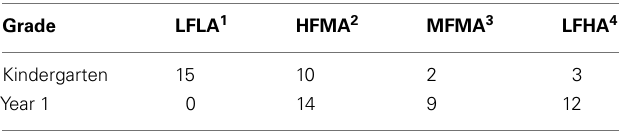
FIGURE 4 | Single-digit addition percentage correct as a function of SDA finger-use